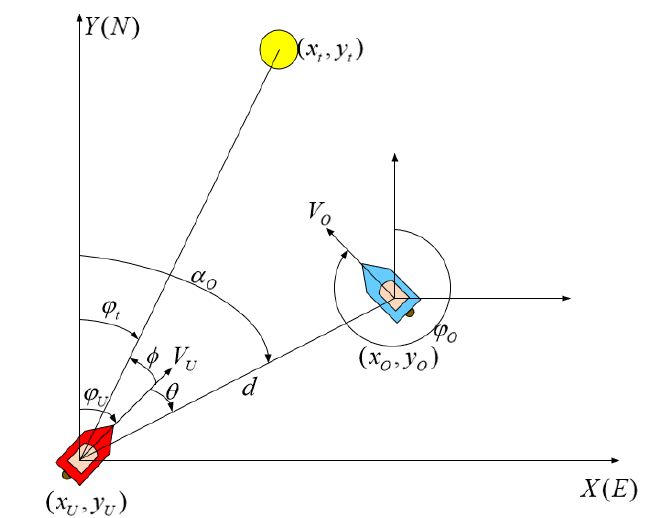
Figure 4. Schematic diagram of USV